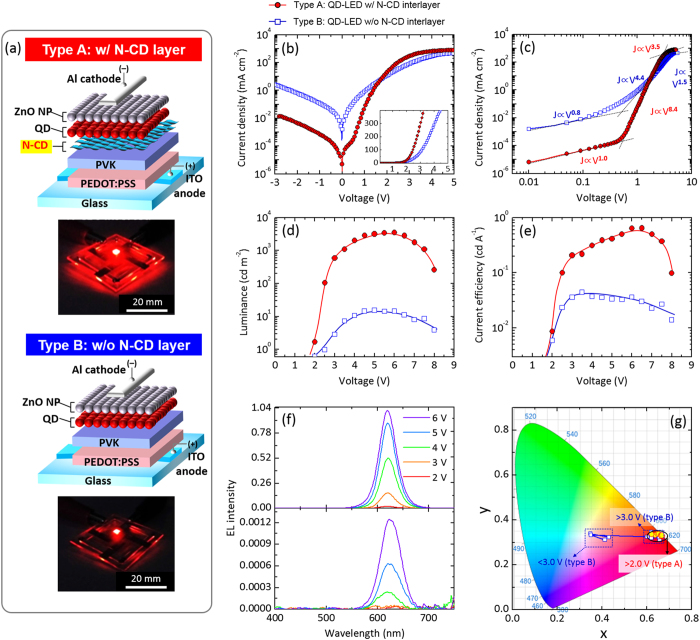
QD-LEDs with/without N-CD interlayer.(a) Schematic illustrations depicting the structures of solution-processed QD-LEDs. The photographs of red emission from both types of QD-LEDs were taken at a driving voltage of 5 V under the same dark room and camera conditions. (b) J–V characteristic curves. Inset is plotted in a linear scale at forward applied voltages. (c) J–V characteristic curves plotted on double-logarithmic axes. (d) Luminance and (e) Current efficiency plotted as a function of applied bias voltage. (f) EL spectra of the N-CD-inserted QD-LED (upper panel) and the control QD-LED (lower panel) at diverse applied voltages. (g) CIE coordinates of EL emission colors measured at various applied bias voltages of 2.0–8.0 V.